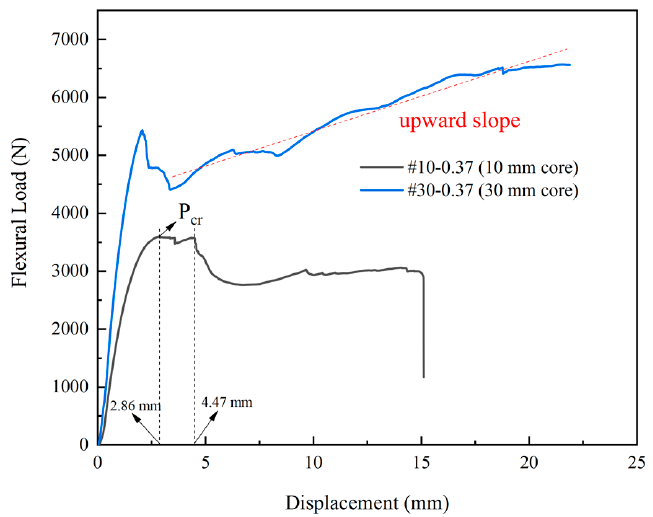
Figure 5. Analysis of flexural load–displacement curves of #10-0.37 and #30-0.37. According to Figure 3b, for the specimens with different densities of core materials, the curves of #20-0.57 and #20-0.75 have the same three stages, namely, the linear elastic stage, nonlinear stage and instability stage, as that of #20-0.37. After the instability stage, the curves of the two specimens with higher core material density are different from that of #20-0.37. As shown in Figure 6, the curves of #20-0.57 and #20-0.75 showed an upward trend at first, and then the flexural load fluctuated from falling to rising when the displacement of the two curves reached 13.88 mm and 15.76 mm, respectively. The curve of #20-0.75 finally showed a vertical decline.